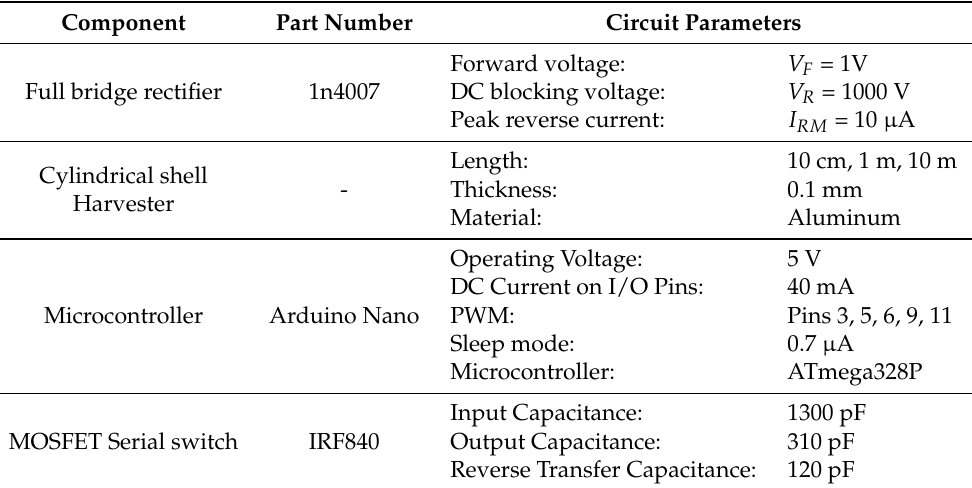
Figure 5. Measurement setup. Table 1. Components and circuit